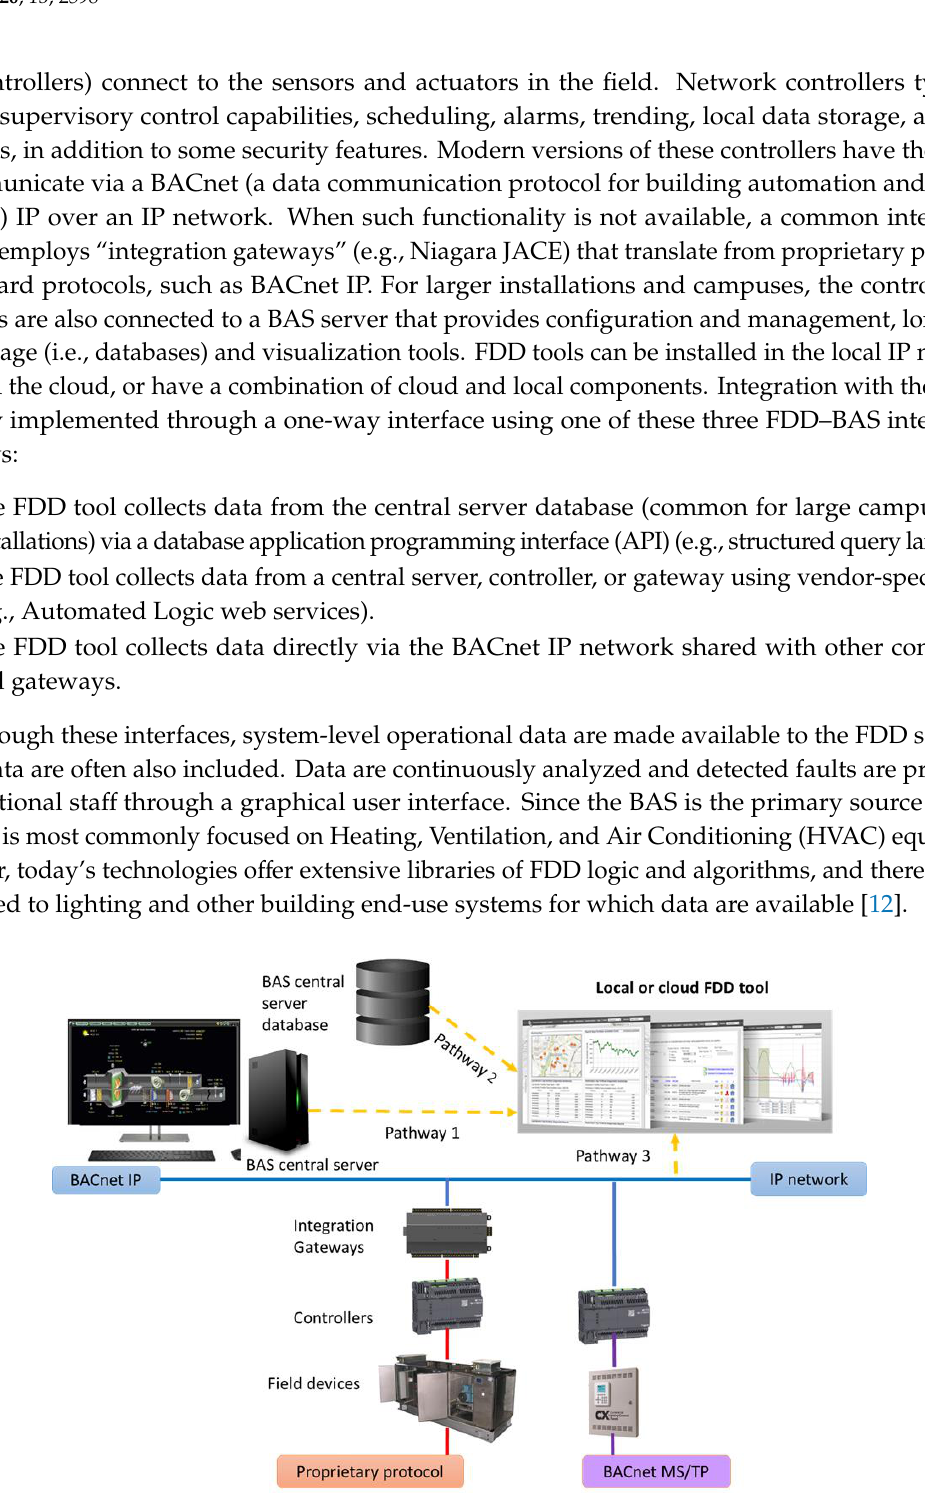
Figure 1. Schematic illustration of the integration of building automation system (BAS) data into fault detection and diagnostics (FDD) products. (BACnet MS/TP - BACnet Master Slave Token Passing protocol).